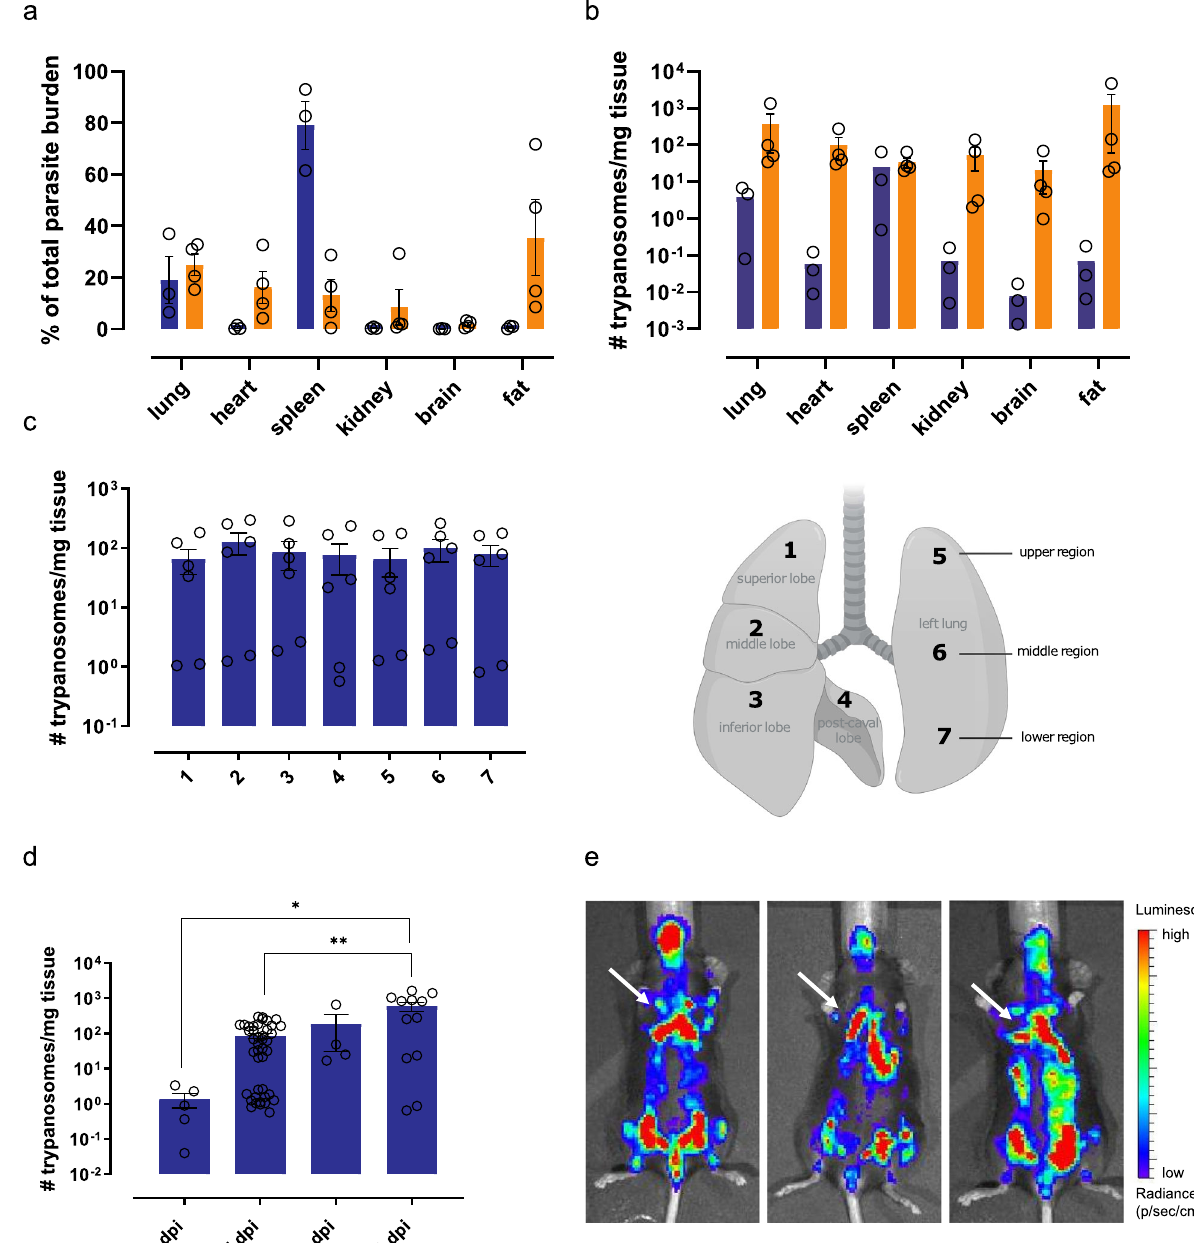
Fig. 1 | Infection dynamics in T. b. brucei infected mice. a – d C57BL/6JRj mice were infected via the bite of a T. b. brucei AnTar1 infected G. morsitans tsetse fl y.